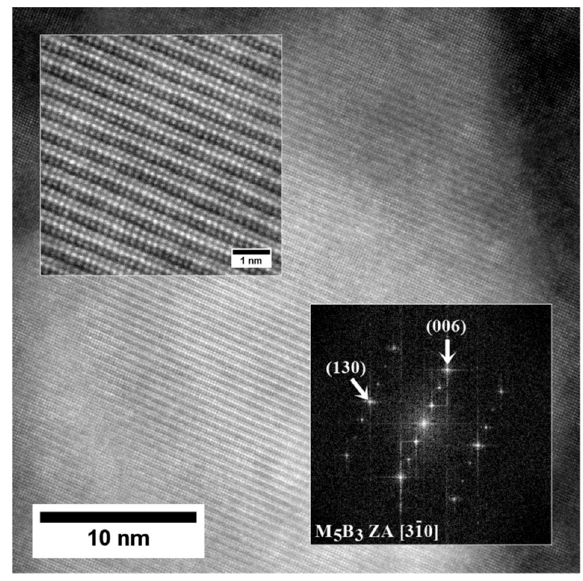
Figure 22. Nanostructure of the M 5 B 3 boride located at grain boundary, HRSTEM-HAADF.